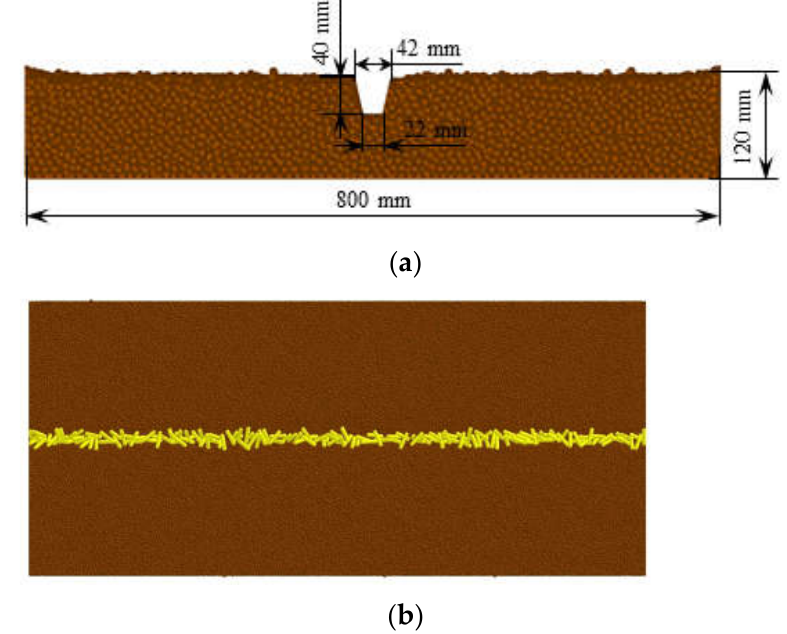
Figure 12. Virtual model of bin. ( a ) Soil; ( b ) Soil-straw